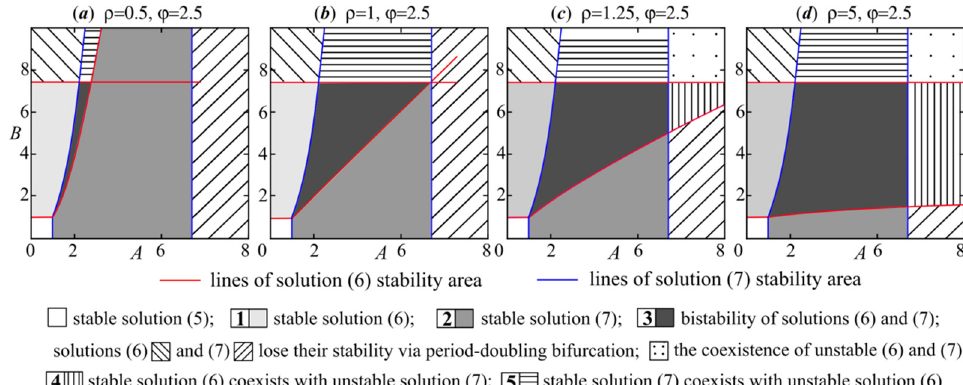
Figure 2. Areas of existence and coexistence of fixed points (5)–(7) for different values of ρ and φ with ρφ > 1.